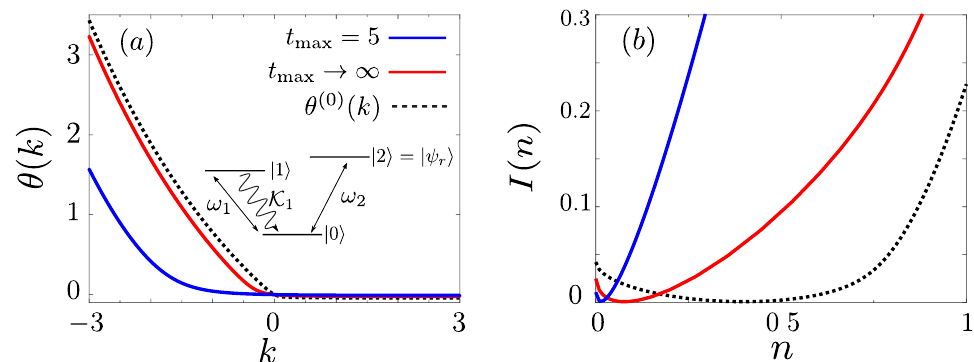
〉 = | 2 〉 . (a) Scaled r = 5 (in units of ω − 1 , max 1 ). The large max = 4, ω = 1 / 10 1 2